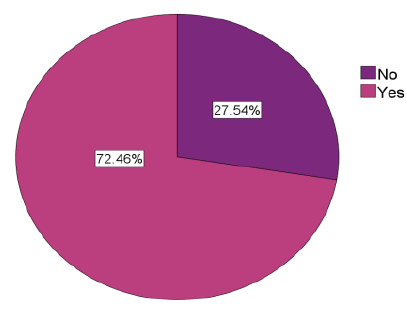
Figure 1: Existence of organization’s policies for agroforestry implementation